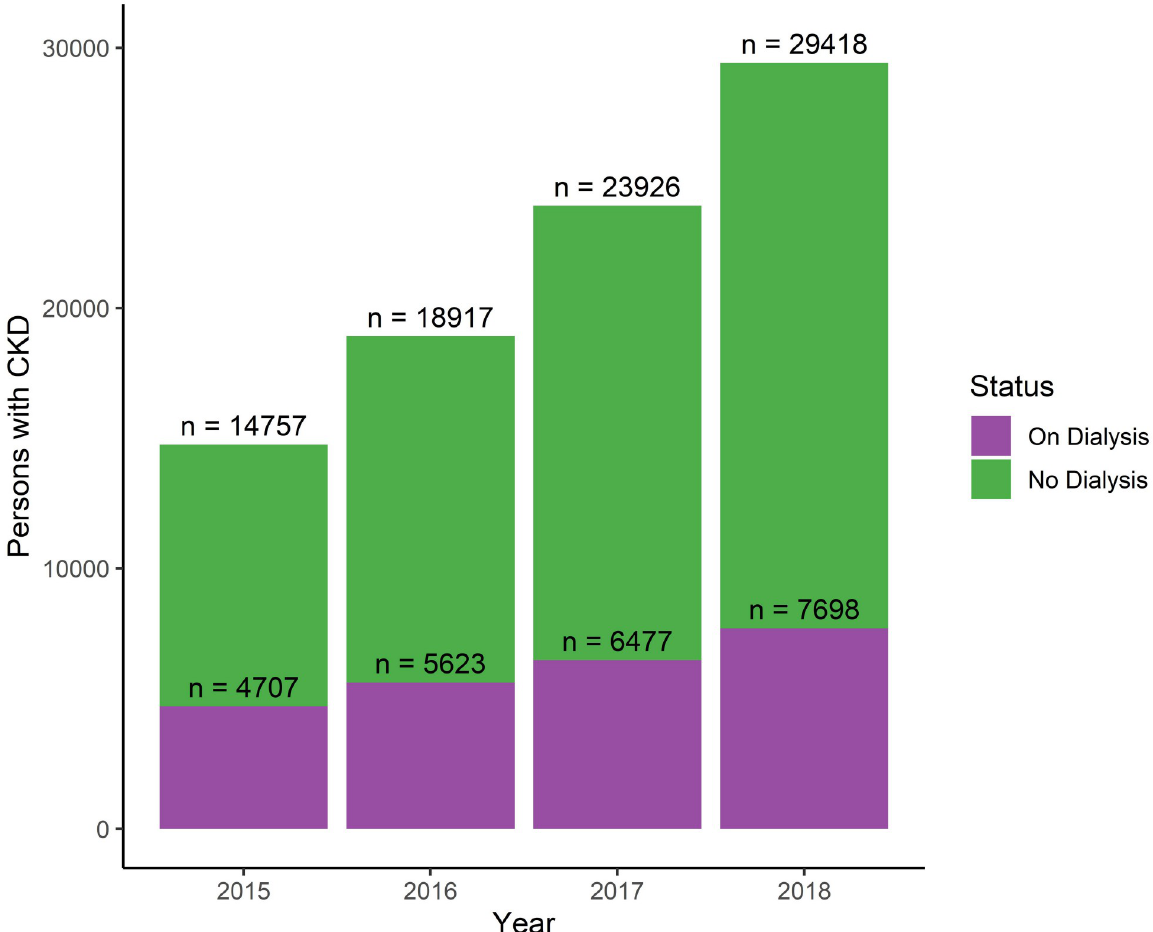
Fig 2. IESS patients with a CKD diagnosis. For each year, the number of individual patients with an N18 diagnosis who received care (emergency, inpatient, or outpatient) billed to the IESS system is given. Colors denote dialysis status.